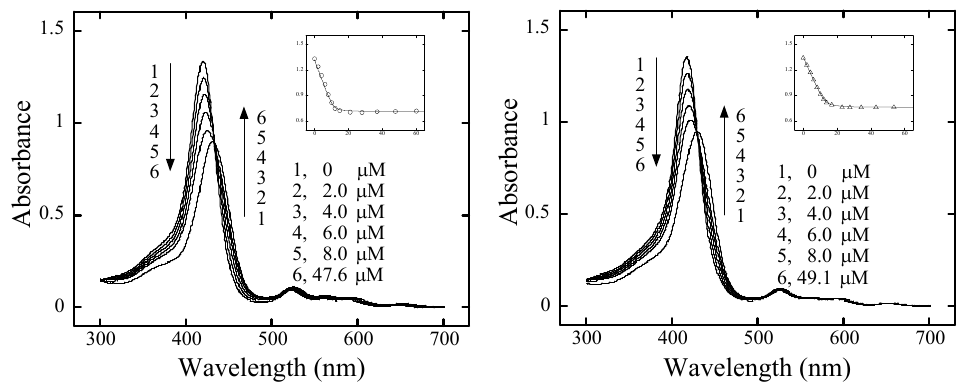
Figure 2 . ( a , left) Absorption spectral change of H absorbance change at 419 nm, ( b , right) absorption spectral change of H addition of CTDNA and absorbance change at 419 nm. Theoretical solid lines were also drawn with the K and n values in Table